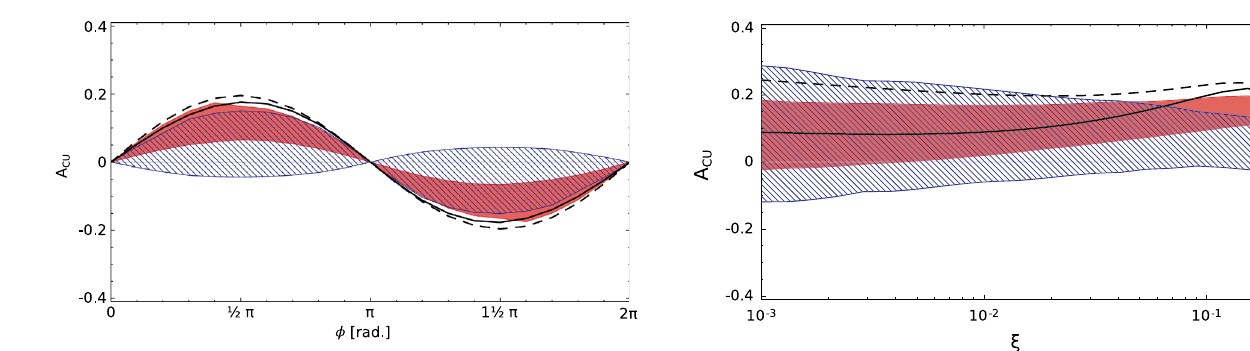
Fig. 7 Circular asymmetry A CU evaluated with LO and NLO spacelike-to-timelike relations for Q (cid:4) 2 = 4 GeV 2 , t = − 0 . 1 GeV 2 and φ = π/ 2 as a function of ξ . The cross sections used to evaluate the asymmetry are integrated over θ ∈ (π/ 4 , 3 π/ 4 ) . For the further description see the caption of Fig.